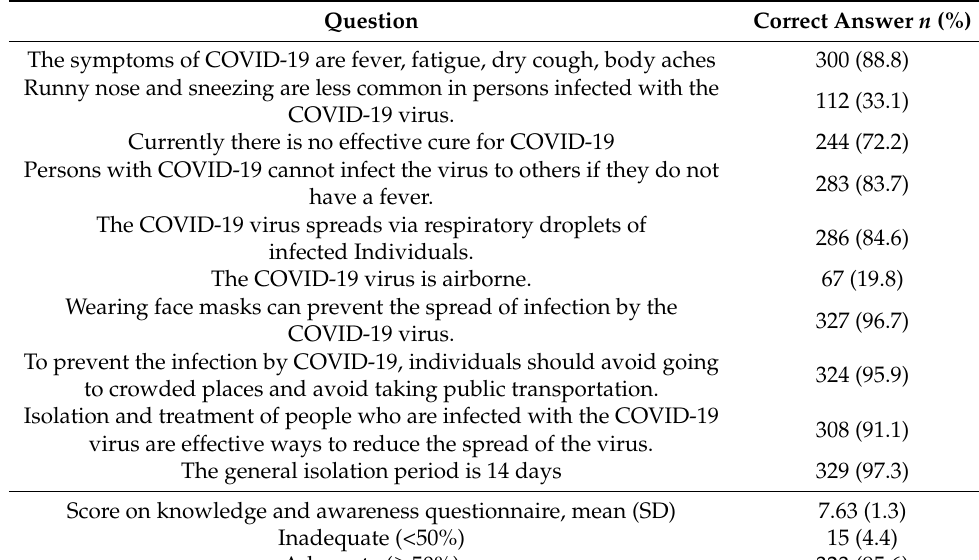
Table 2. Knowledge of COVID-19.